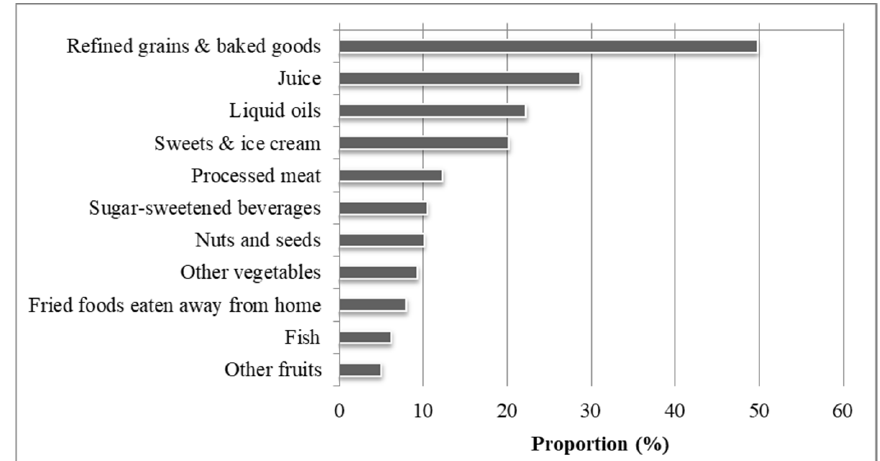
Figure 3. Snacks purchased by 534 out of 1059 in ‐ school adolescents over the previous 24 h. Note: Snacks consumed by <5% of the students are listed here: low fat dairy, red meat, deep orange fruits, high fat dairy, whole grains, dark green leafy vegetables, white roots and tubers, legumes, deep orange vegetables, citrus fruits, hot beverages, eggs, deep orange tubers, poultry, and cruciferous vegetables.